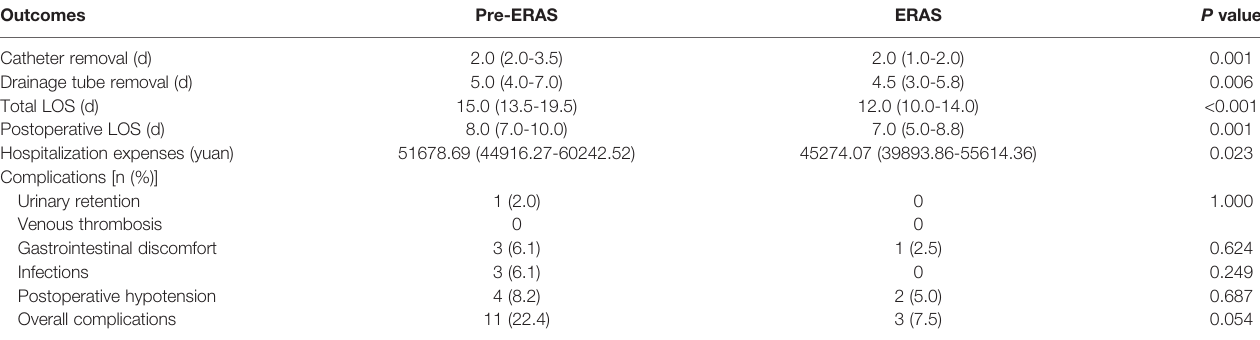
TABLE 4 | A comparison of the outcomes between pre-ERAS and ERAS.